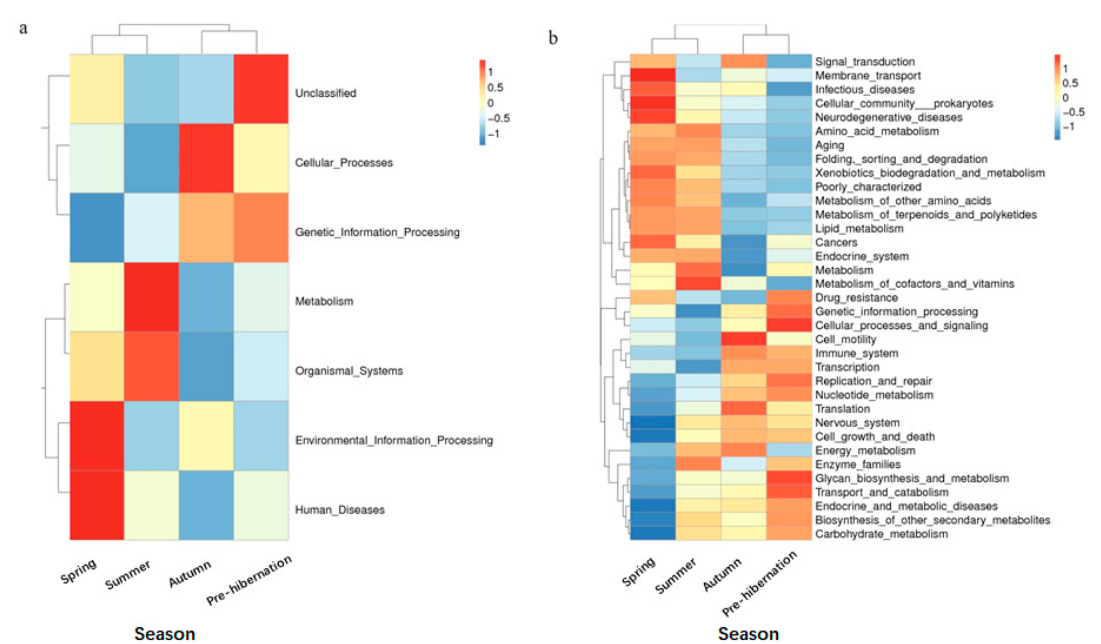
Figure 4. Cluster heatmap of annotated function by Tax4Fun. ( a ) The main function in level 1. ( b ) The metabolism functions in level 2. In the figure, the horizontal ordinate represents the sample information and species annotation information; the cluster trees on the left and the top are species clustering and sample clustering, respectively; middle heat map matching is the Z-value. Z-value is obtained after standardized treatment of relative abundance of species. It is the difference between the relative abundance of a sample in this classification and the average relative abundance of all samples in this classification divided by the standard deviation of all samples in this classification.